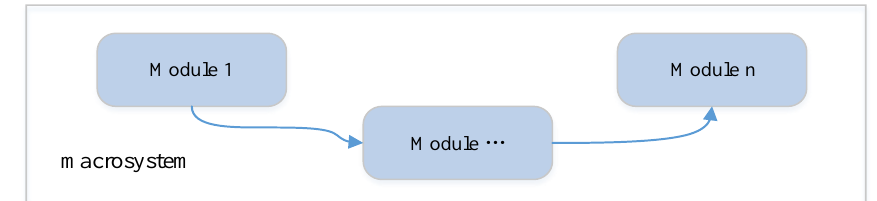
Figure 16. Static processing on macrosystem.